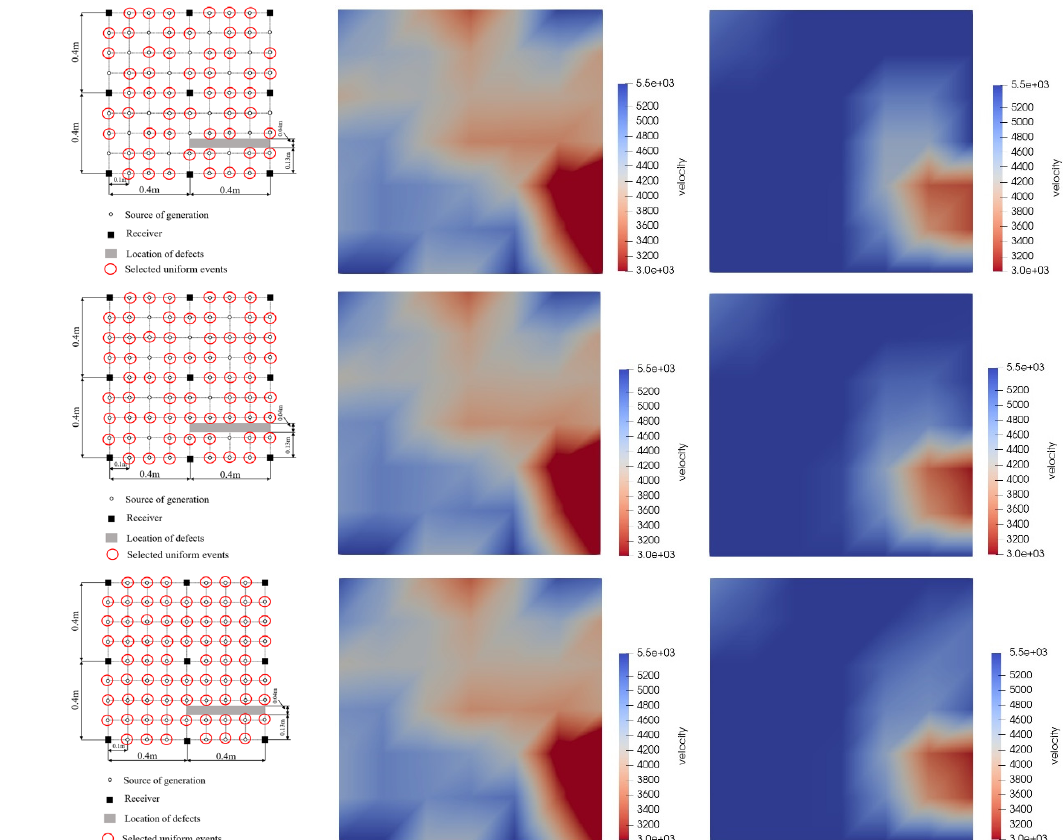
Figure 16. Different numbers of events for the velocity distribution results by the LASSO and SIRT algorithms.